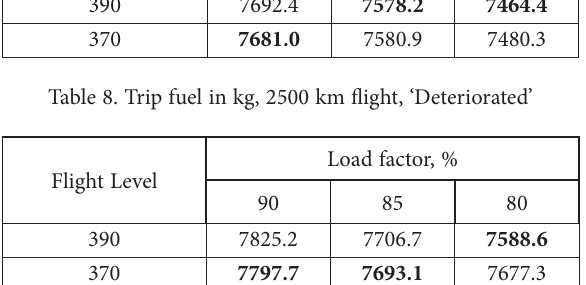
Table 11. Trip fuel in kg, 2000 km flight, ‘New’